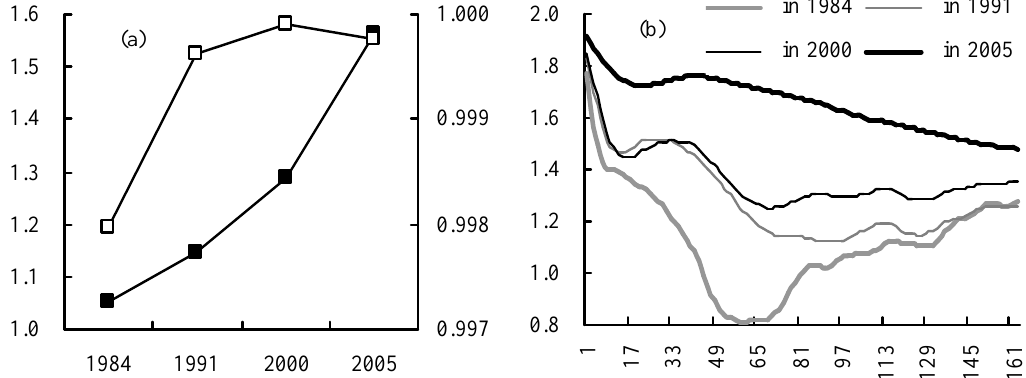
Figure 6. (a) Fractal correlation dimension, left y-axis and solid black rectangle for dimension (dimensionless), right y-axis and hollow white rectangle for correlation coefficient (dimensionless), x-axes for time (in year); (b) the scaling behavior, y-axis for α (dimensionless), x -axis for ε (in pixel).